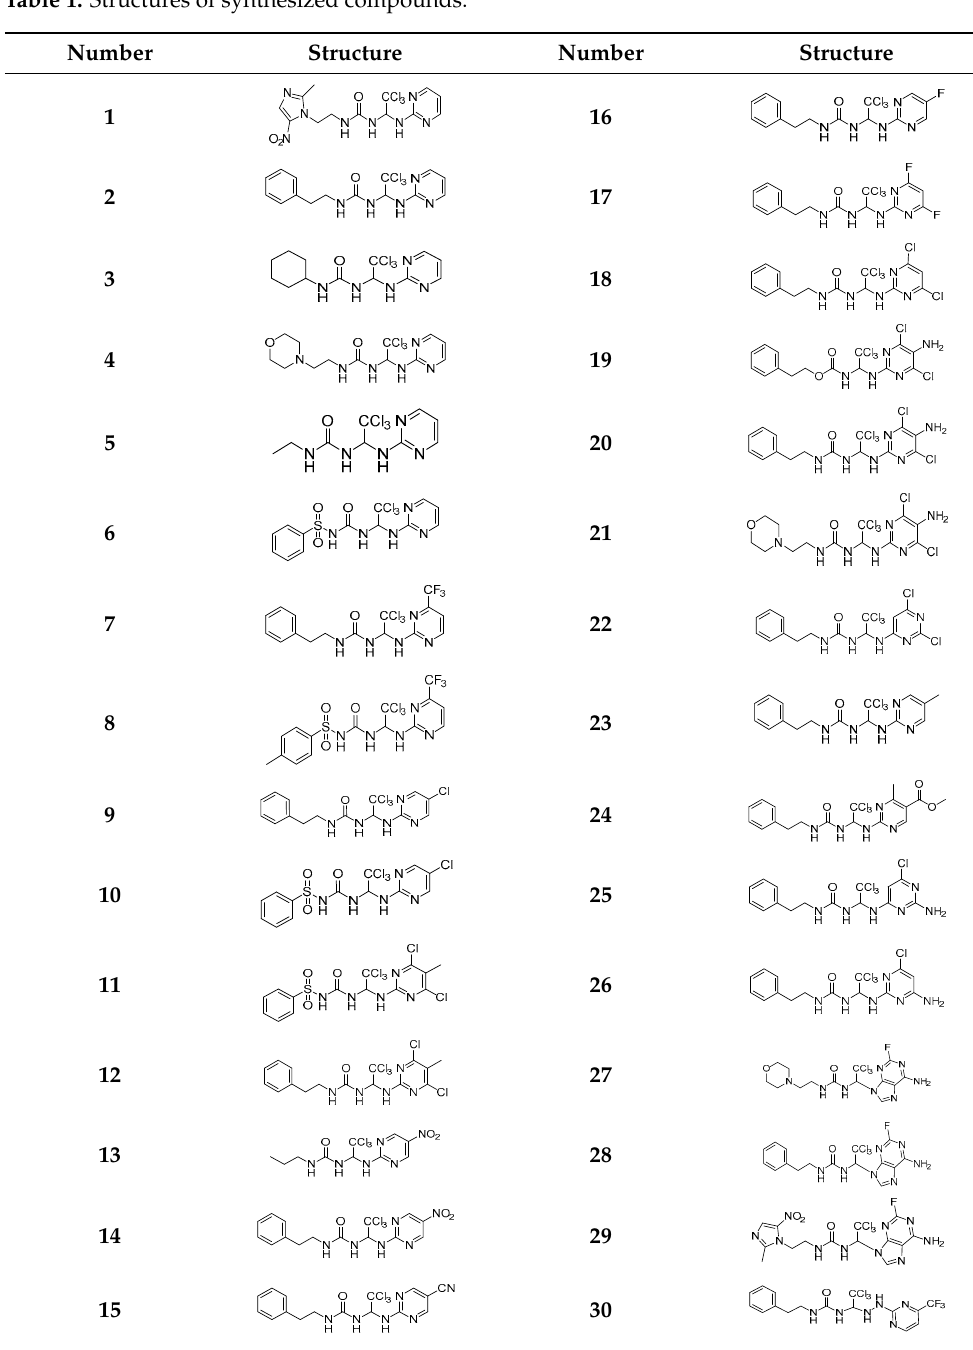
2.2. In Vitro Antiproliferative Assay and Prediction of Lipid Permeability and Toxicity in Silico